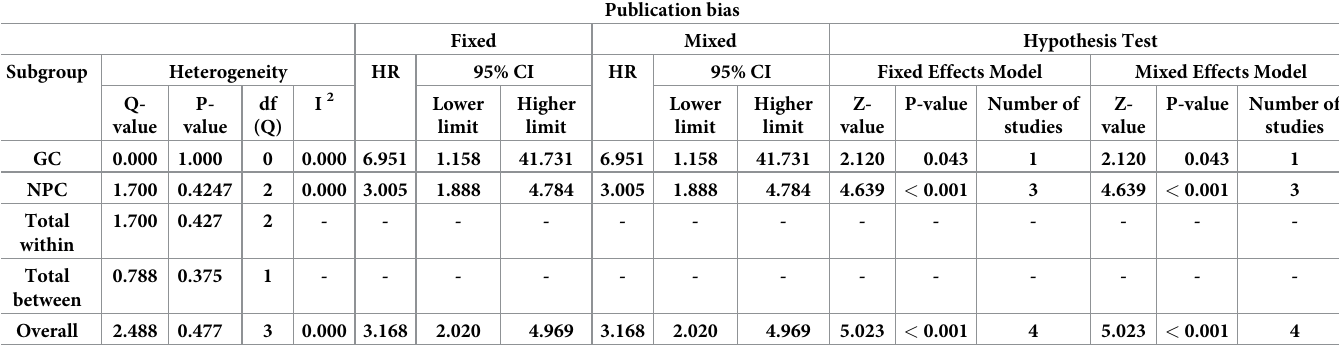
Table 2. The heterogeneity, publication bias and hypothesis testing of the included studies in the